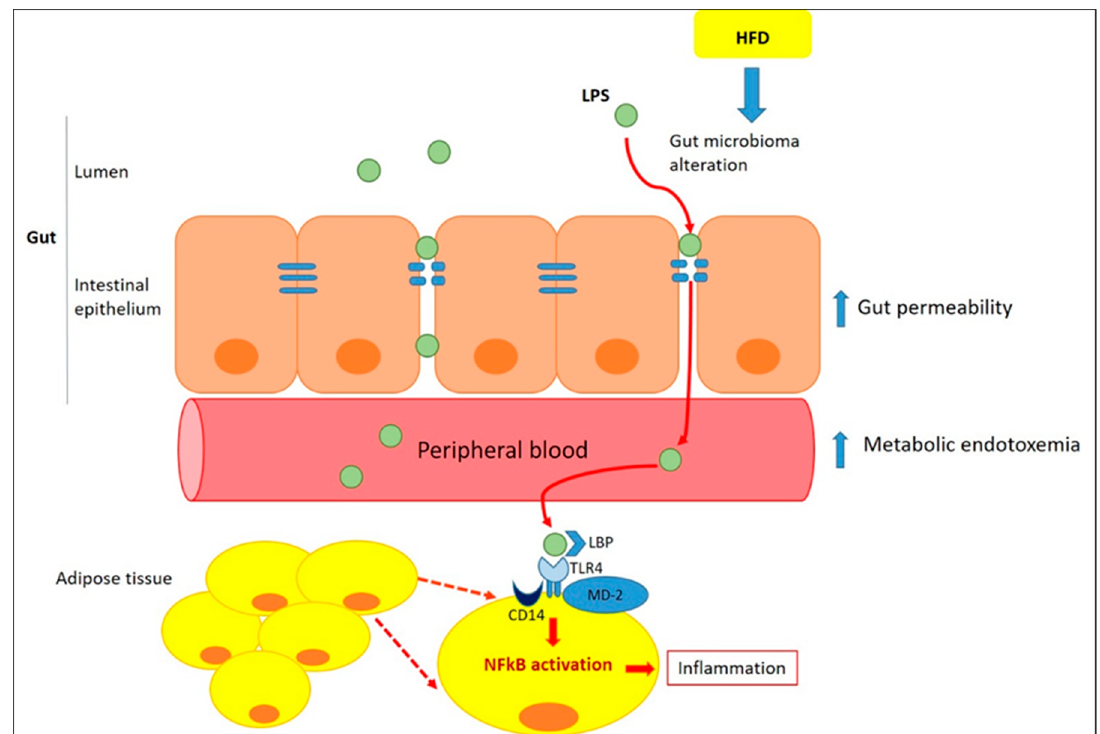
Figure 1. Role of gut in inducing adipose tissue inflammation. Inflammation alters the gut barrier function through a reduction in the thickness of the intestinal mucus layer and a subsequent increase in gut permeability [18]. Lipopolysaccharide (LPS), trigger inflammation in adipocytes and, along with macrophage colony-stimulating factor (M-CSF), infiltrated from the intestine, promotes ATM recruitment within the mesenteric fat depot [19]. Once in the circulation, LPS could reach adipose tissue and acts as a Toll-like receptor agonist (TLR)-4, increasing the expression of proinflammatory markers [20]. TLR4 binds to LPS through the formation of a complex with LPS-binding proteins (LBP), MD-2 (myeloid differentiation factor 2) and CD14 (cluster of differentiation 14). This complex activates the myeloid differentiation primary-response protein 88 (MyD88)-dependent pathway leading to Nuclear factor- κ B (NF- κ B) activation and to transcription of proinflammatory genes both in adipocytes and ATM [21,22].